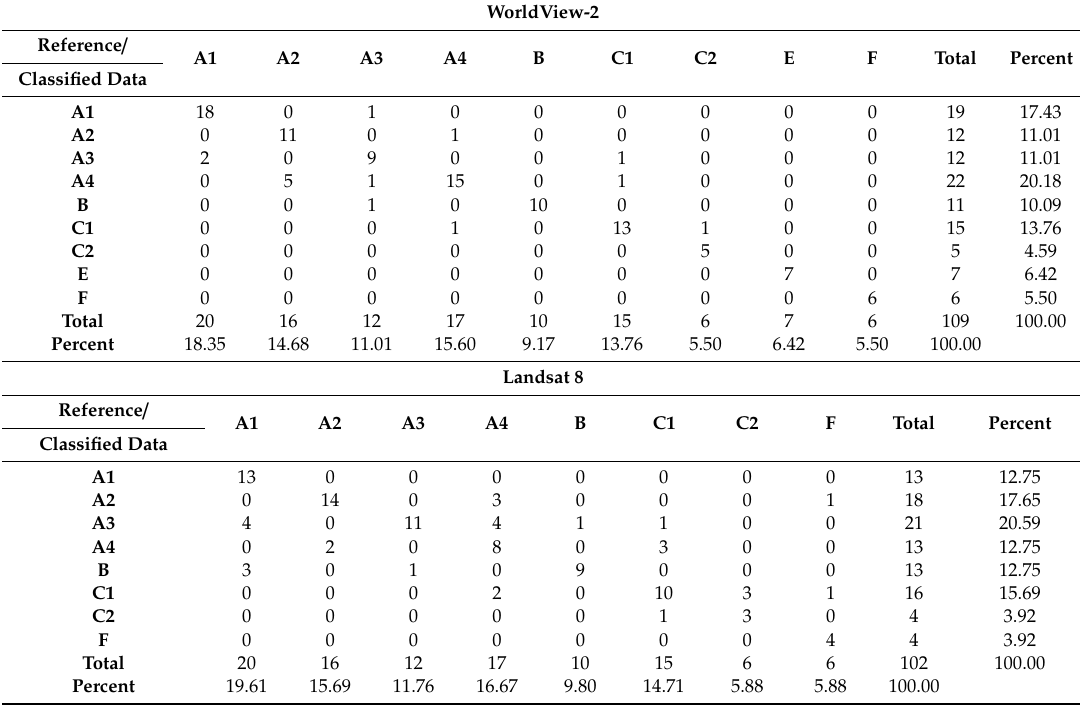
Table A1. Accuracy Assessment Matrix SVM—Combination 5.